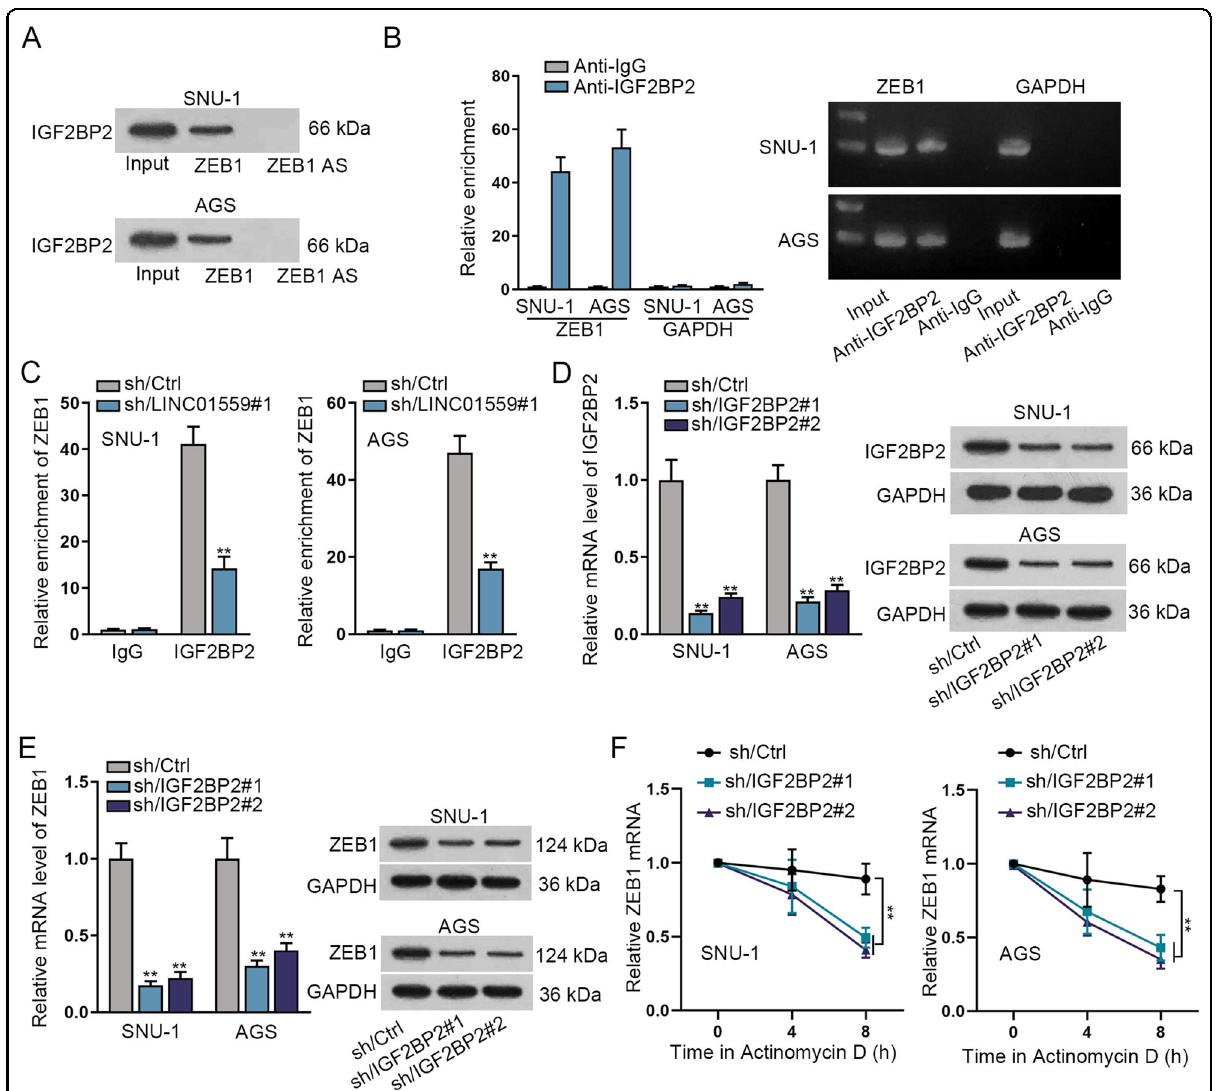
Fig. 5 LINC01559 recruits IGF2BP2 to stabilize ZEB1 mRNA in GC cells. A RNA pull-down experiment was conducted to detect the enrichment of IGF2BP2 in ZEB1 groups. B RIP assay showed the enrichment of ZEB1 in anti-IGF2BP2 groups, with GAPDH as the negative control of ZEB1 mRNA. C RIP assay detected the changes in the enrichment of ZEB1 by anti-IGF2BP2 in GC cells with LINC01559 silencing. D , E RT-qPCR and western blot analyses assessed the mRNA level and protein level of IGF2BP2 and ZEB1 in GC cells transfected with sh/Ctrl or sh/IGF2BP2#1/2. F The stability of ZEB1 mRNA in GC cells with or without IGF2BP2 interference was assessed by RT-qPCR after treating with Actinomycin D. ** P <